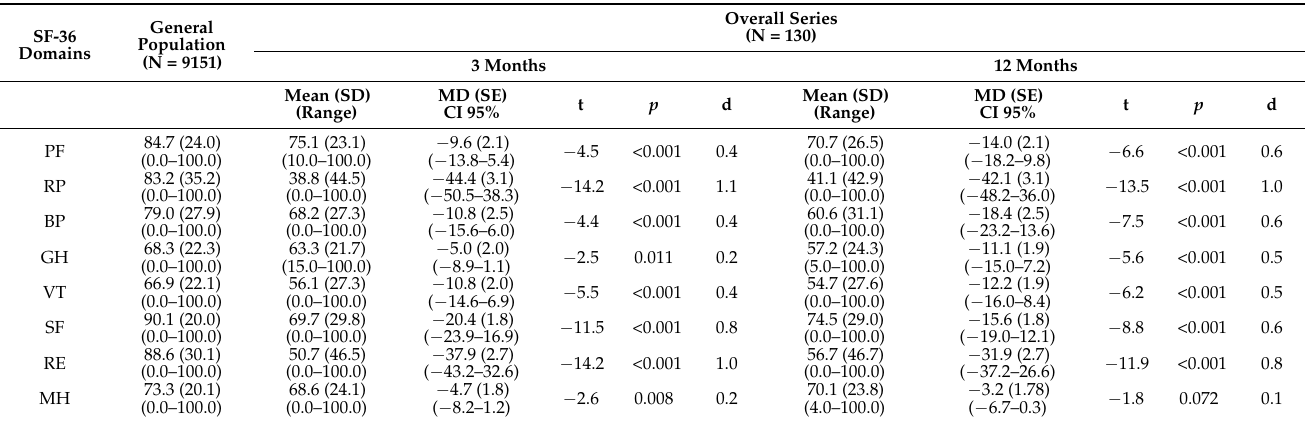
Table 3. Values of the scores of the domains of the SF-36 questionnaire in the Spanish population (reference) and in the present study.